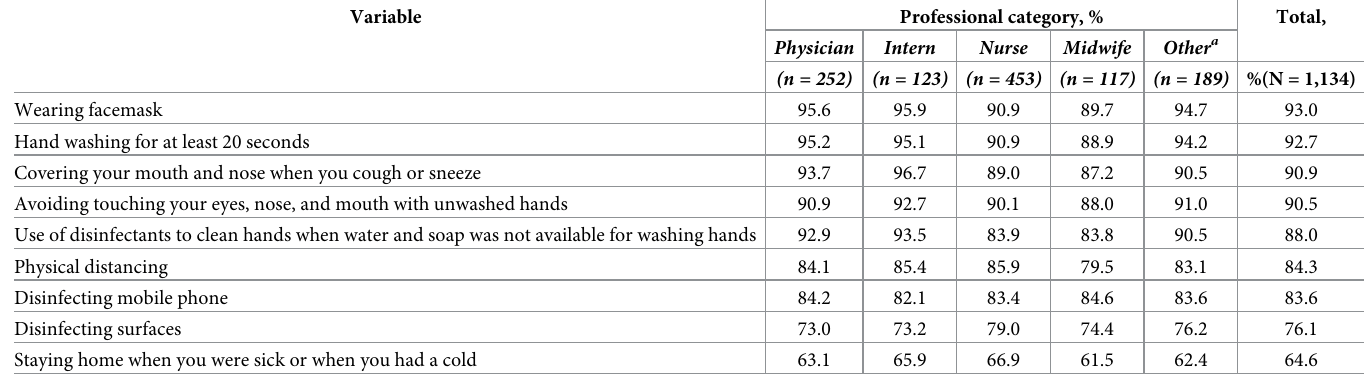
Table 2. Self-reported prevalence of preventive measures practiced by healthcare professionals to prevent coronavirus infection by professional category (N =